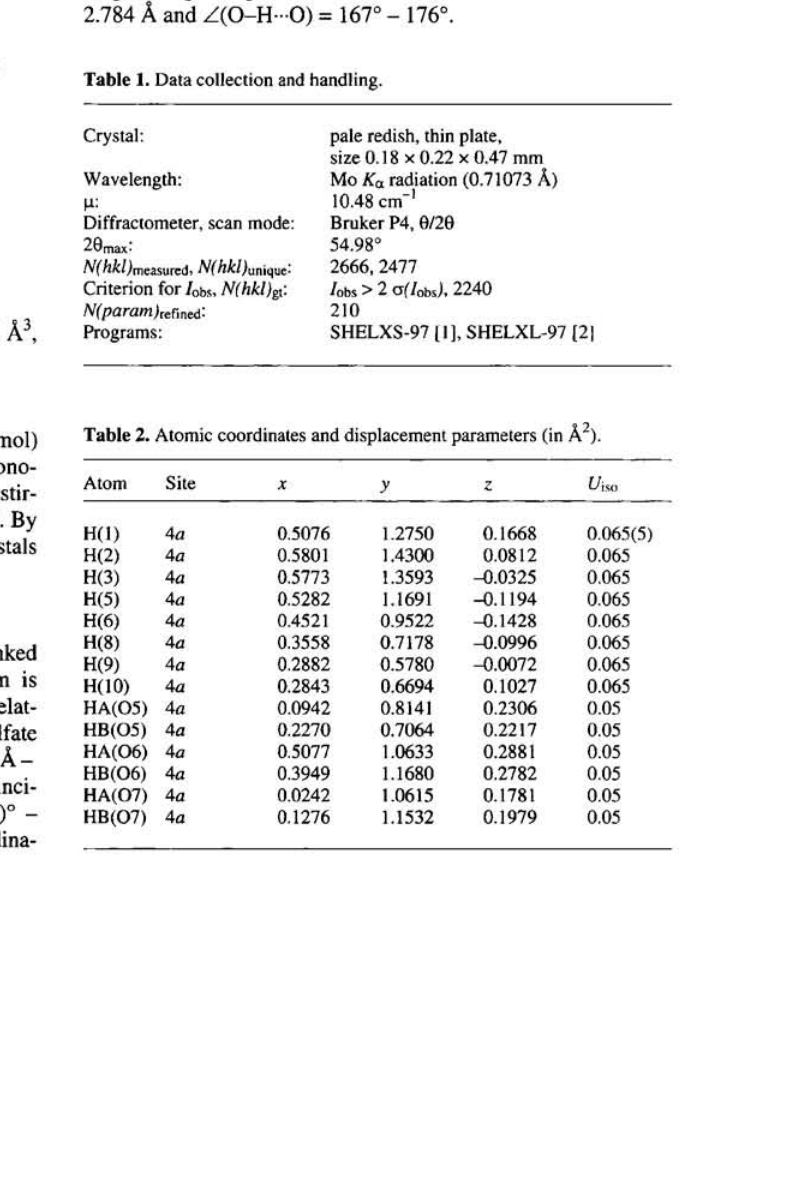
Table 1. Data collection and handling.